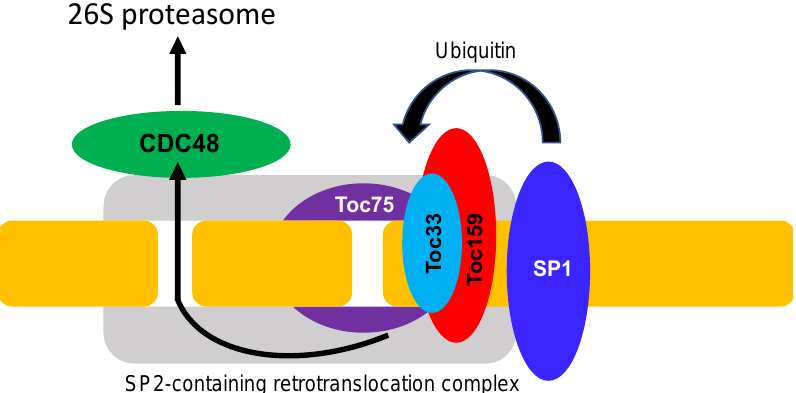
Figure 2. CHLORAD of TOC complex components. The RING-type E3 ubiquitin ligase SP1 directs the ubiquitination of TOC complex subunits. SP2-containing retrotranslocation and CDC48 complexes act to extract ubiquitinated TOC complex subunit proteins to the 26S proteasome in the cytosol for degradation.